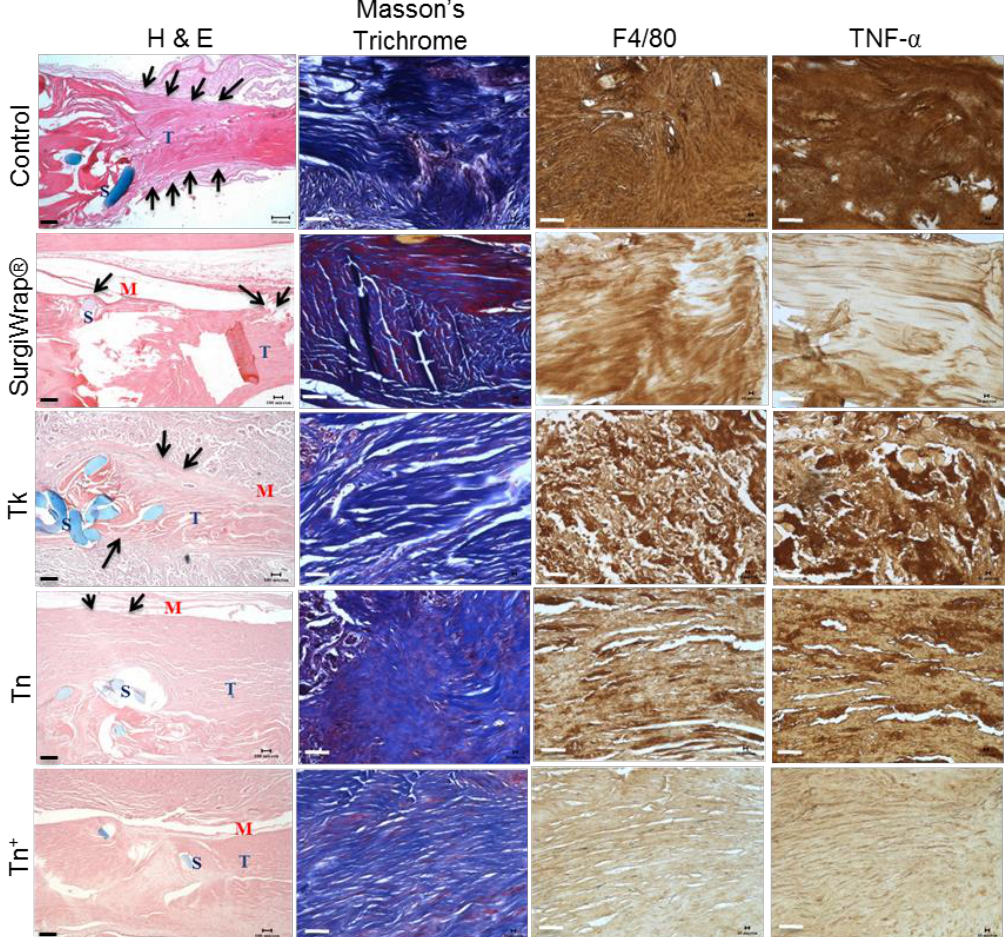
Figure 14. The histological analysis of untreated tendons (control group), tendons treated with SurgiWrap ® , and tendons treated with Tk, Tn, or Tn + CSNFMs. The hematoxylin-eosin (H&E) staining shows adhesion tissues around repaired tendon (black arrows) as well the position of suture (S), tendon (T), and membrane (M) (bar = 200 μm). The Masson’s trichrome stain and immunohistochemical (IHC) staining of TNF-α and F4/80 are included (bar = 50 μm).